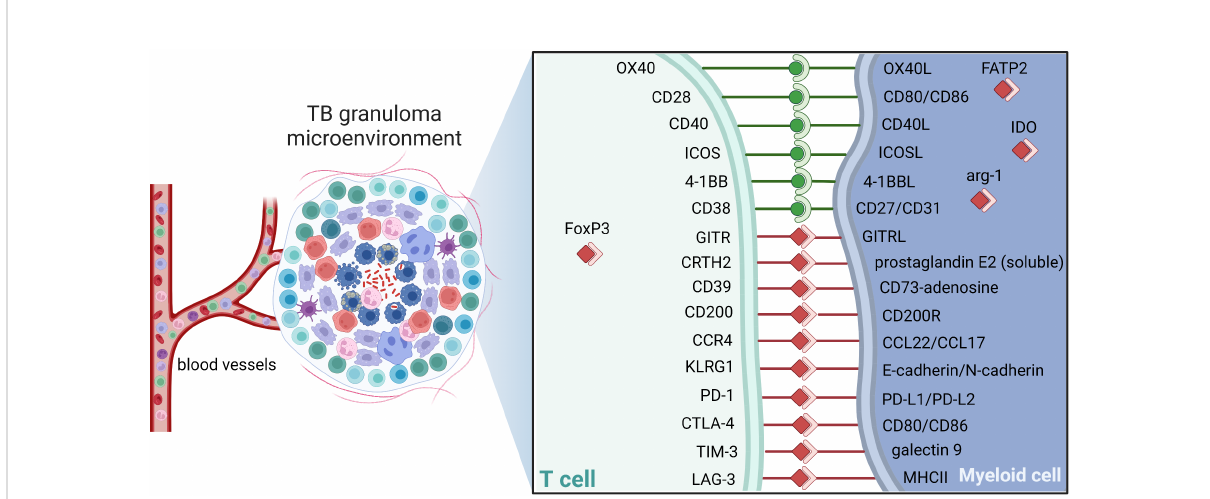
FIGURE 5 Checkpoint molecules dictate TB control. Schematic of potential immune checkpoint molecules of relevance in TB that can contribute to activation (green) or suppression (red) in the granuloma. Note that selected receptor-ligand pairs are shown and does not represent a global description immune checkpoint molecules. Cell-cell interactions between CD3+ T cells and host macrophages are illustrated. ICOS, Inducible T-cell COStimulator; GITR, glucocorticoid-induced TNFR-related protein; CRTH2, Prostaglandin D2 receptor 2; KLRG1, Killer cell lectin-like receptor subfamily G member 1; CCR4, C-C chemokine receptor type 4; PD1, Programmed cell death protein 1; PD-L1, PD1 ligand; CTLA-4, cytotoxic T-lymphocyte-associated protein 4; TIM-3, T-cell immunoglobulin and mucin-domain containing-3; LAG3, Lymphocyte-activation gene 3; MHCII, major histocompatibility complex II; FoxP3, forkhead box P3; IDO, Indoleamine 2,3-dioxygenase; Arg, arginase; FATP2, Fatty acid transport